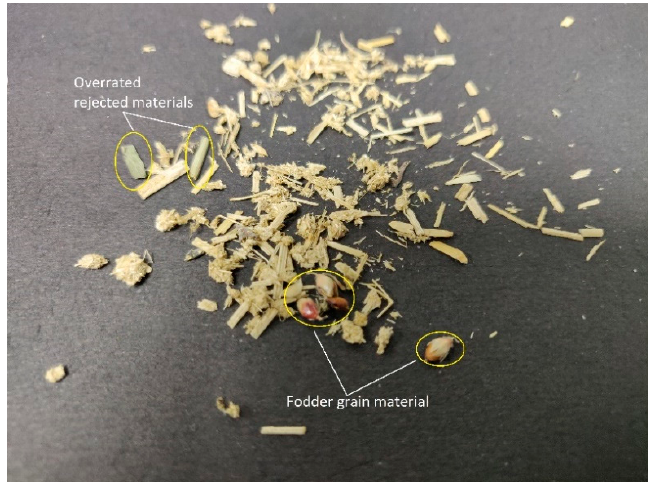
Figure 2. Overrated rejected materials (Green fodder, Grains etc.).